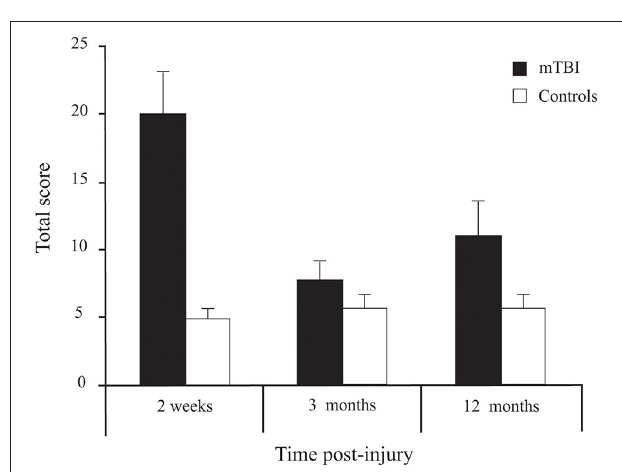
FIGURE 6 | Between-Group differences (Mean ± SEM mTBI vs. Mean ± SEM Controls) for Total Score on the Post-Concussion Symptom Scale—Revised as a function of Time post-injury